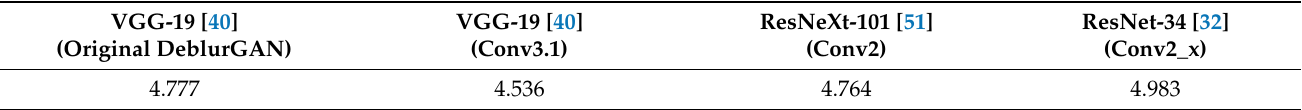
Table 8. Comparison of finger-vein recognition error (EER) of restored images in PolyU-DB according to the perceptual loss based on the various CNN models and layers (unit: